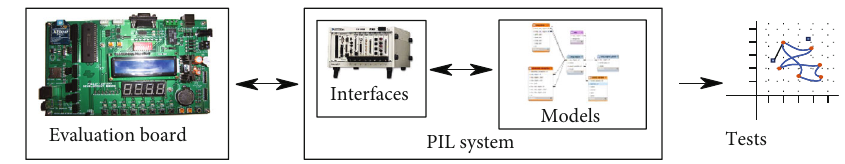
Figure 3: PIL veri fi cation paradigm.